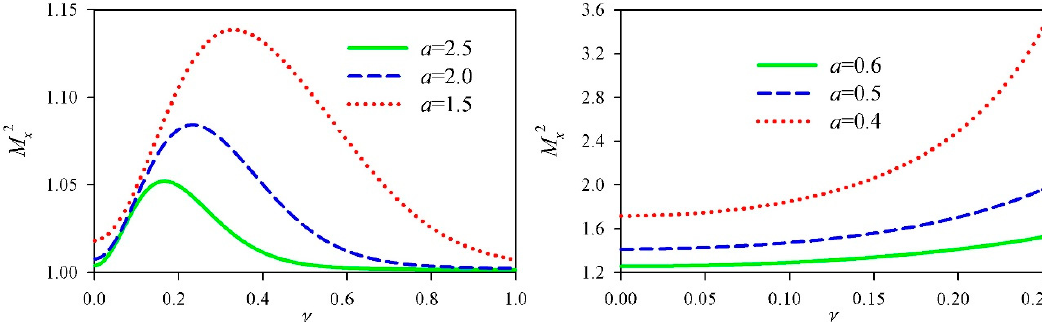
Figure 1. M x 2 factor of the cosh-Airy beam as functions of the parameters a + and a − .